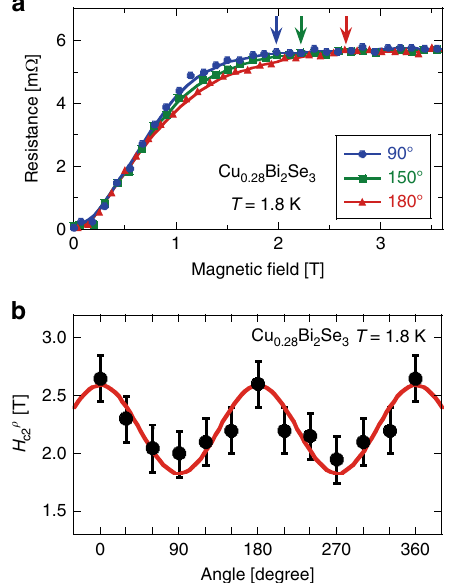
Fig. 6 In-plane upper critical fi eld anisotropy determined by magneto- resistance. a Electrical resistance at T = 1.8 K as a function of the magnetic fi eld for three representative in-plane angles. The arrows indicate H which is de fi ned as the fi eld below which the data point deviates from a straight line drawn from the normal state. b Upper critical fi eld H ρ de fi ned in ( a ) is plotted as a function of in-plane angle. The error bar was estimated by assuming that the uncertainty equals twice point-interval in measuring the resistance vs. fi eld curve. The red curve is a sine function.